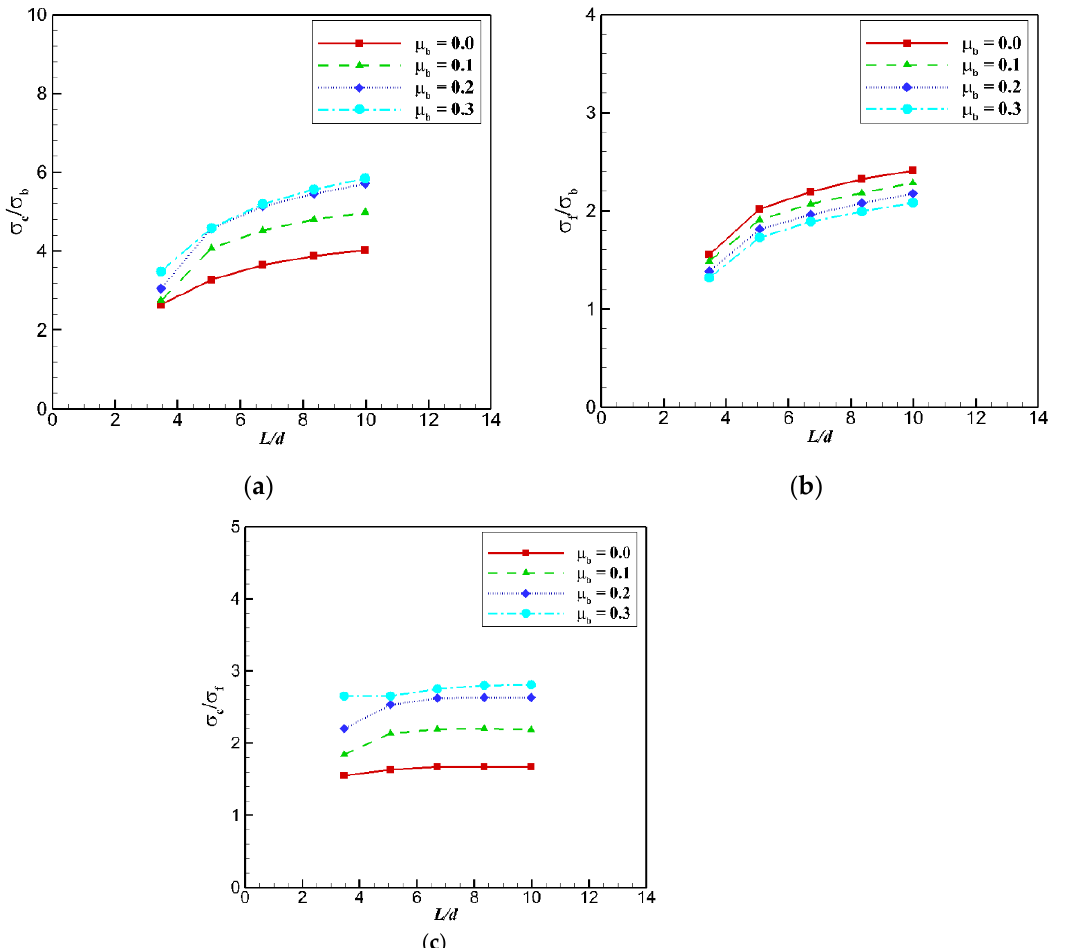
ice strength ratio ( 𝜎